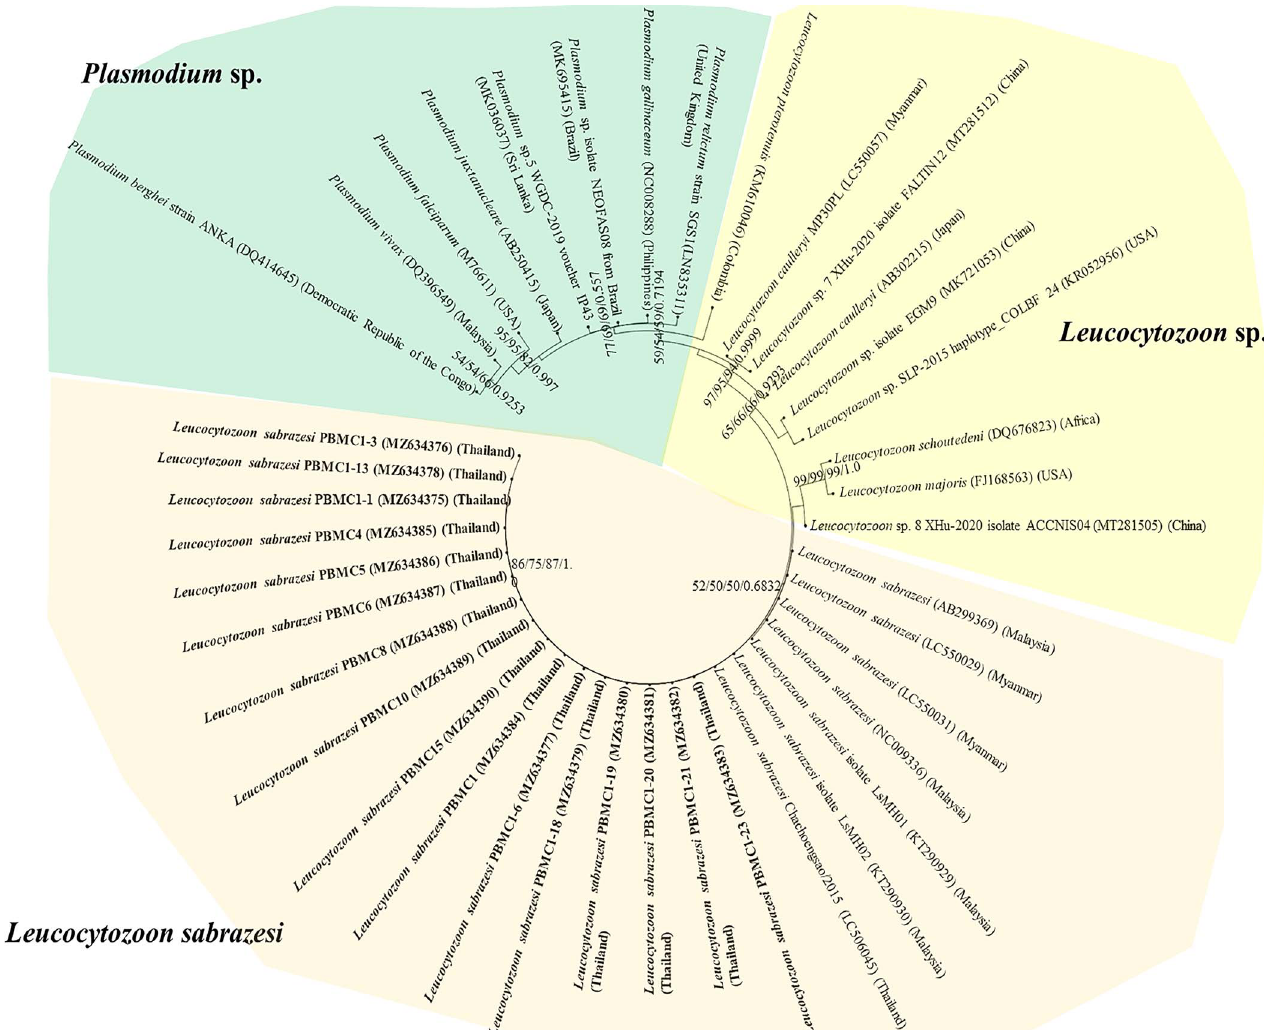
Fig. 1. Phylogenetic tree of the cytb gene sequences in this study (bold face) and those taken from GenBank. The boostrap values calculated from NJ, ML, MP and BA are labeled on each